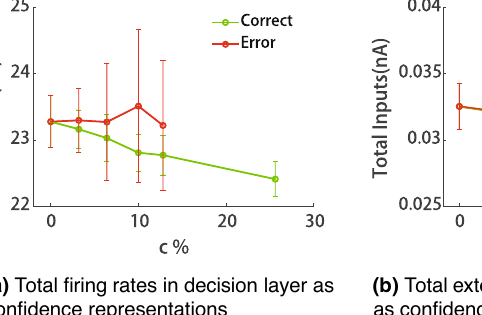
(c) The absolute difference between the firing rates of decision neurons as confidence